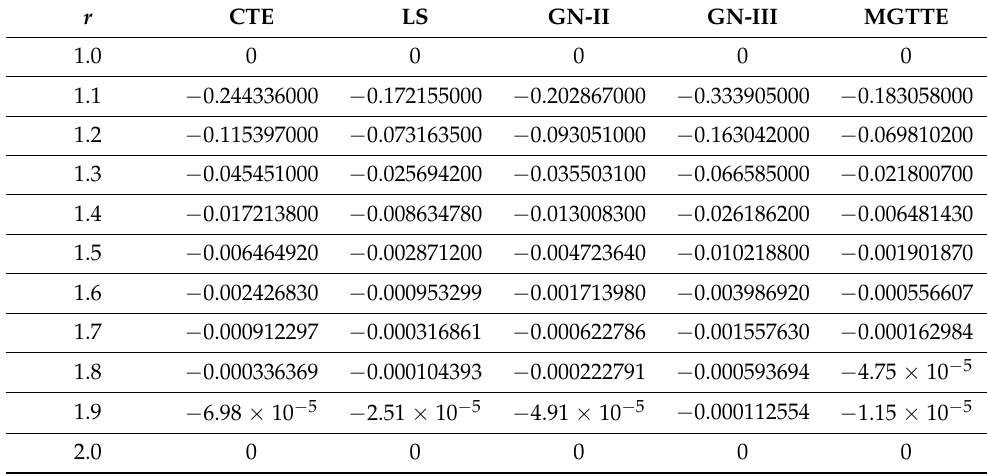
Table 3. The radial stress, σ rr , versus different models of thermoelasticity.